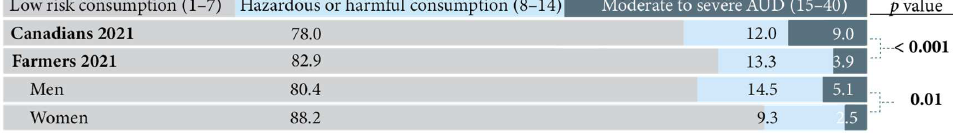
Figure 3. Classification of low risk consumption, hazardous or harmful consumption, and moderate to severe alcohol use disorder (AUD) for the overall 2021 sample and by gender, in comparison to the Canadian general population during COVID-19 from the Canadian Centre on Substance Use and Addiction and Mental Health Commission of Canada’s Mental Health and Substance Use During COVID-19 survey.